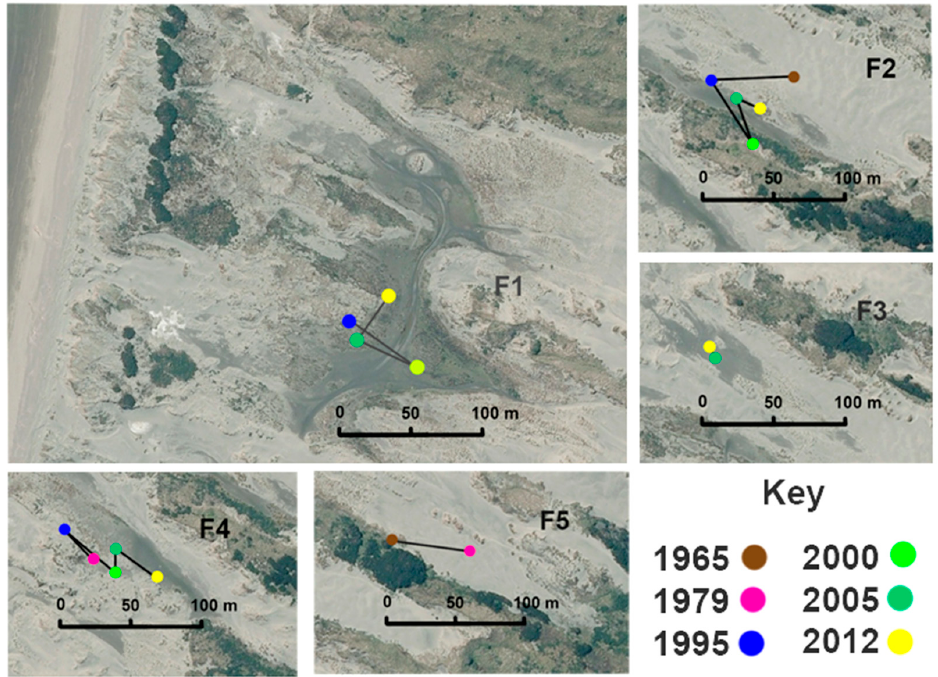
Figure 7. Location and movement of the centroid of each wetland through time in Foxton Beach. The aerial photo of 2012 is used as the basal image. F1 is the W-shaped wetland, formed by coalescence of two adjacent parabolic systems, and kept open by vehicle tracks.